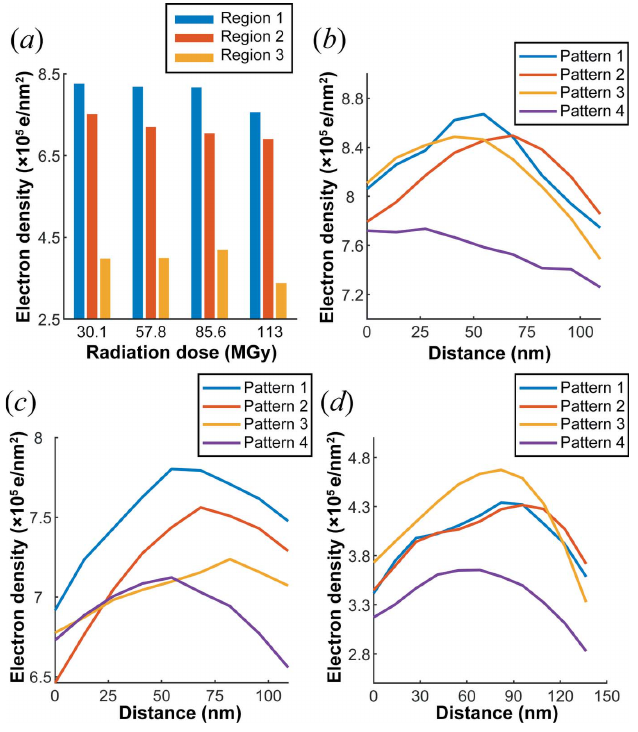
Figure 8 ( a ) The electron density of the regions in Fig. 7. ( b )–( d ) The lateral electron density calculated by vertically averaging the electron densities of Regions 1 to 3 under different